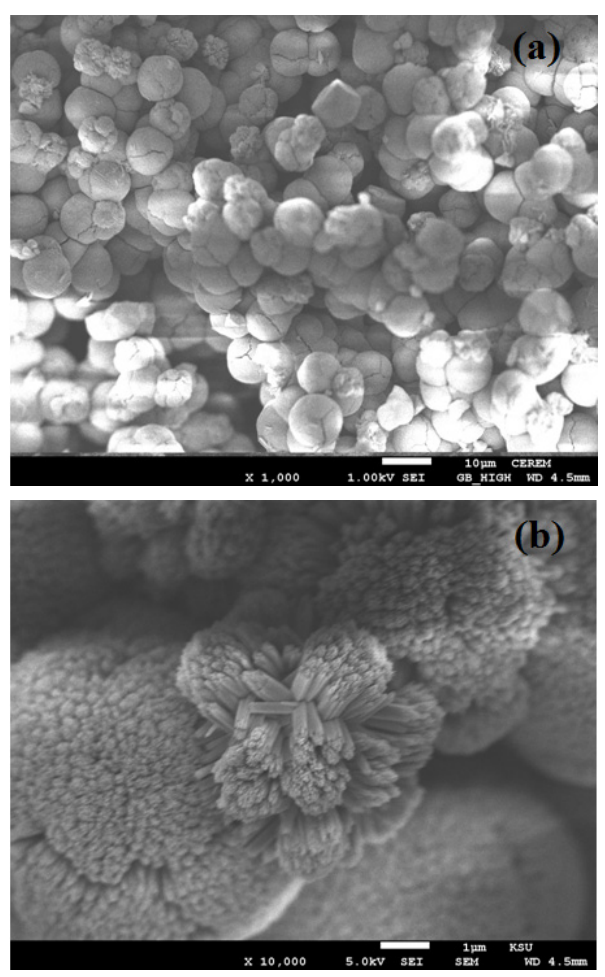
Figure 3. Field emission scanning electron microscopy images of hierarchical TiO 2 structure. ( a ) at low resolution (1000 X); ( b ) at high resolution (10,000